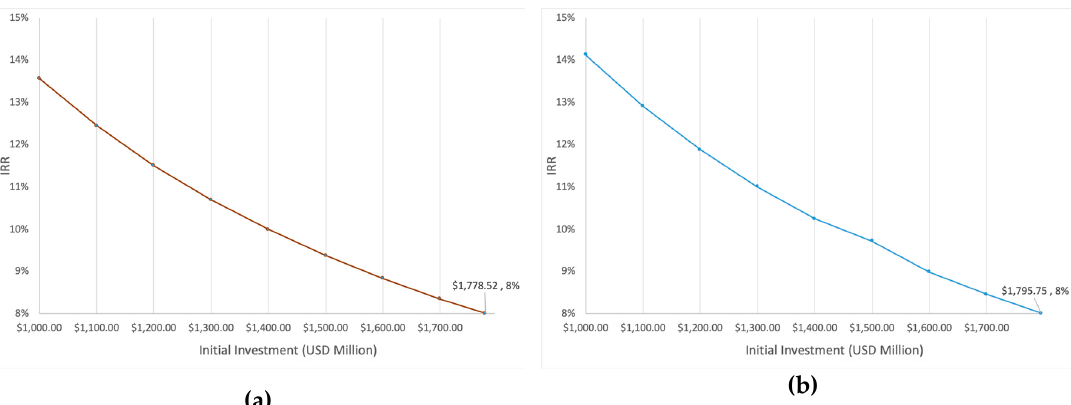
Figure 9. Investment versus IRR based on 30-year lifespan for ( a ) A-USC and ( b ) A-USC (RT).